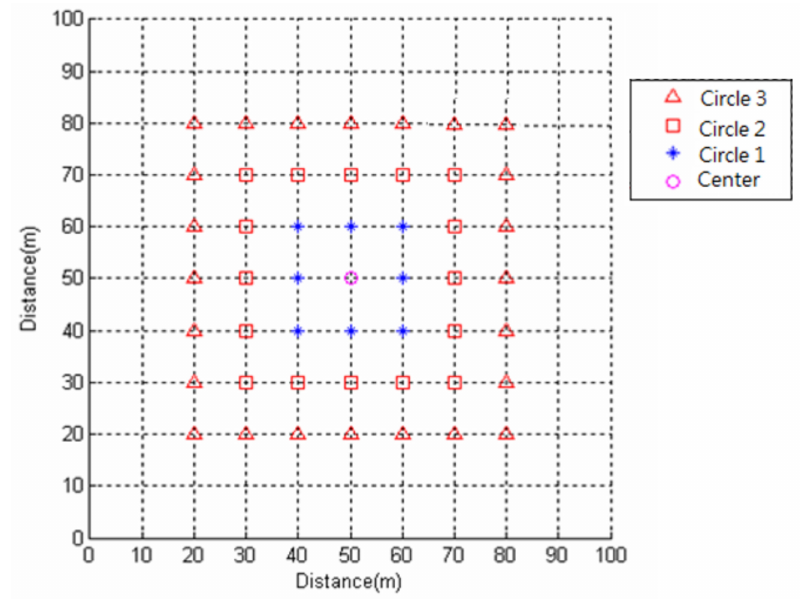
Figure 14. Simulation range is about 100 m × 100